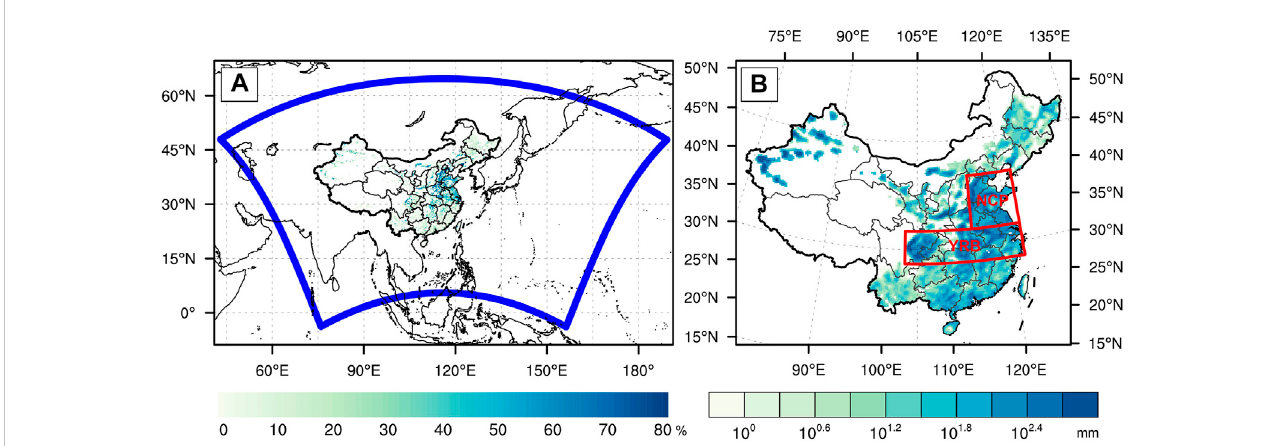
FIGURE 1 The simulation domain of the RegCM and the inputdata of areas equipped for irrigation over China, units: % (A) and the simulated ensemble mean of annual total irrigation amounts over China, units: mm (B) . Note that the thick blue lines in (A) are the boundaries of the domain, the red boxes in (B) represent areas of interest with intense irrigation activities. “ NCP ” for the North China Plain (32.5 – 40 ° N, 114 – 122 ° E) and “ YRB ” for the Yangtze River Basin (28 – 32.5 ° N, 103 – 122 °